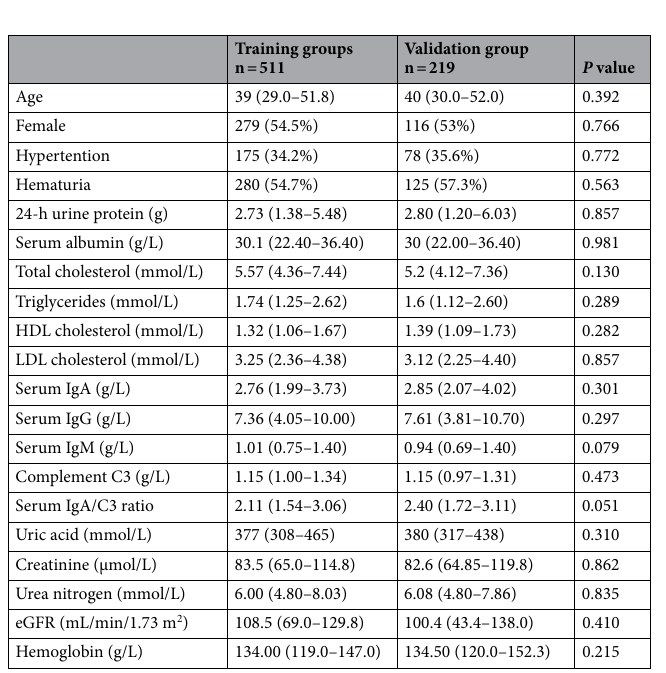
Table 1. Clinical characteristics of the training and validation groups. IgA: immunoglobulin A; IgG: immunoglobulin G; IgM: immunoglobulin M; eGFR: estimated glomerular filtration